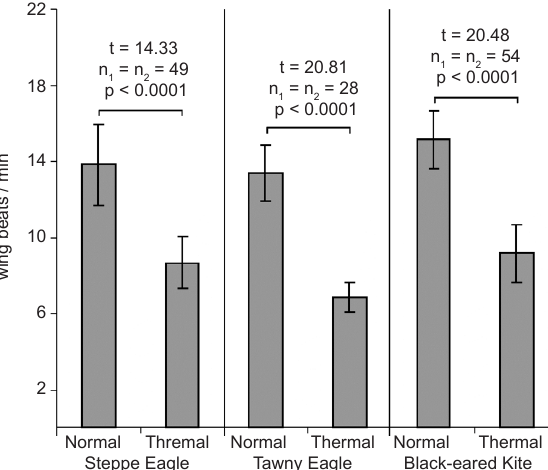
Figure 1. Mean and standard deviation of temperatures at three sites: garbage dump, stage post and surroundings. The temperature difference between three sites is significant (F